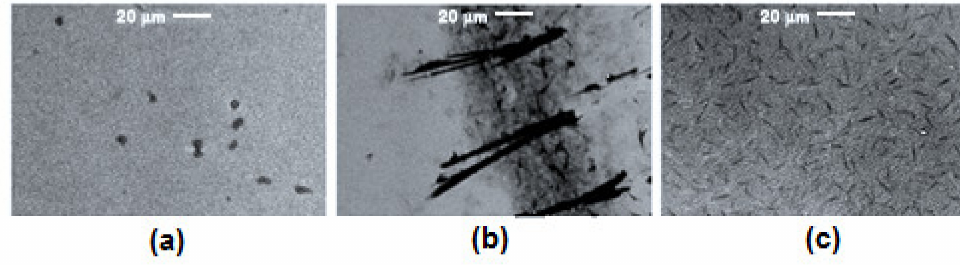
Figure 8. SEM micrographs of ( a ) PEDOT:PSS/MP, ( b ) PEDOT:PSS/MP/graphene and ( c ) PEDOT:PSS/MP/MoO 3 films.